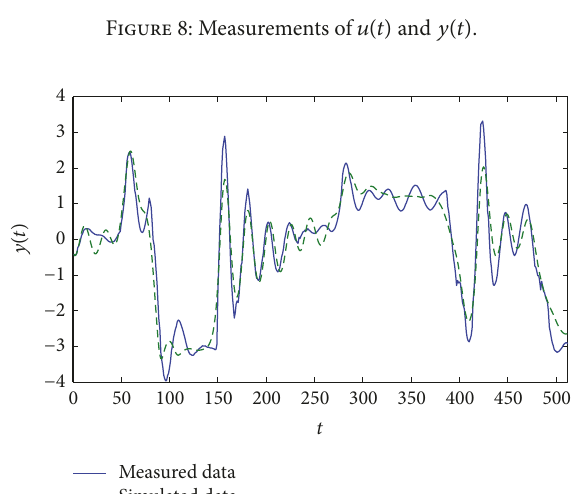
Figure 9: Simulated result with quasi-ARX RBFN model for the real system.